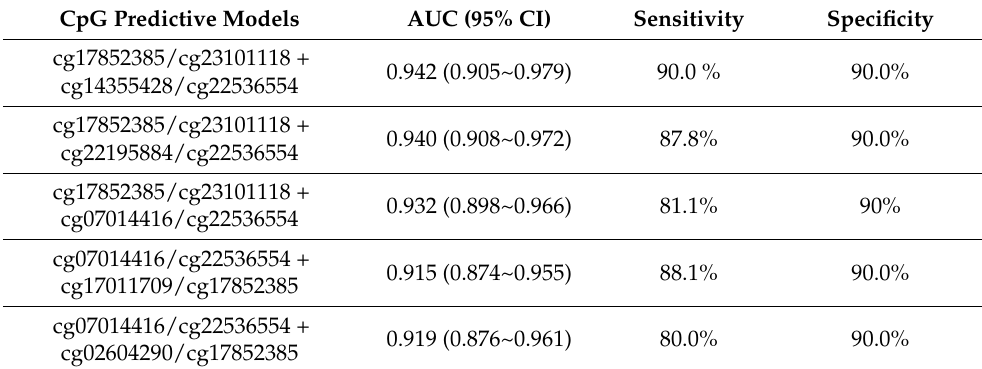
Table 3. Performance of these same top predictive models in the independent validation group (10 patients with Alzheimer’s disease (AD) vs. 10